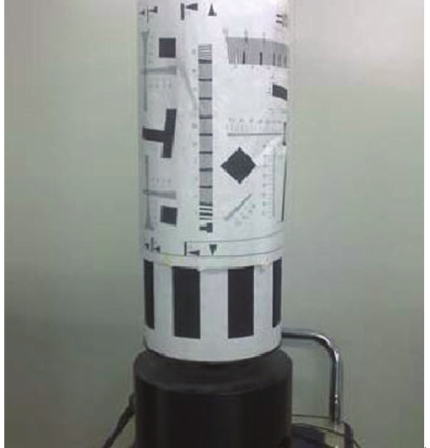
Figure 18: The rotating cylinder as a target.